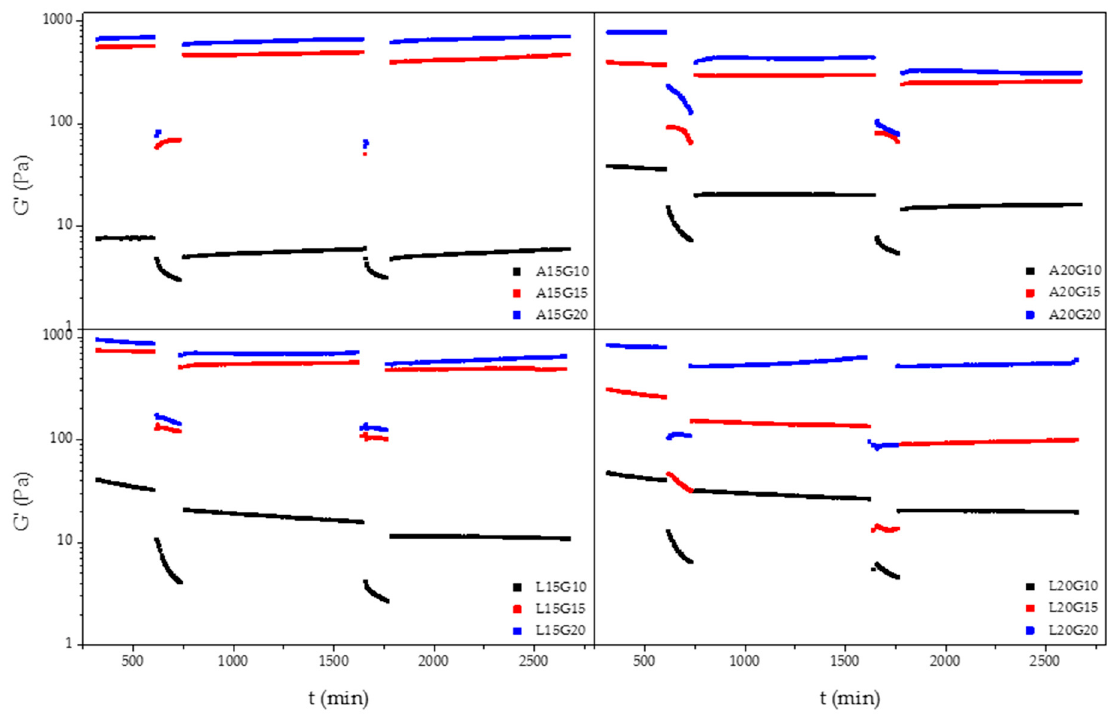
Figure 6. Representative 3 − step loop rheological thixotropic test for hydrogels with difference amounts of ADA, f − ADA, and gelatin.